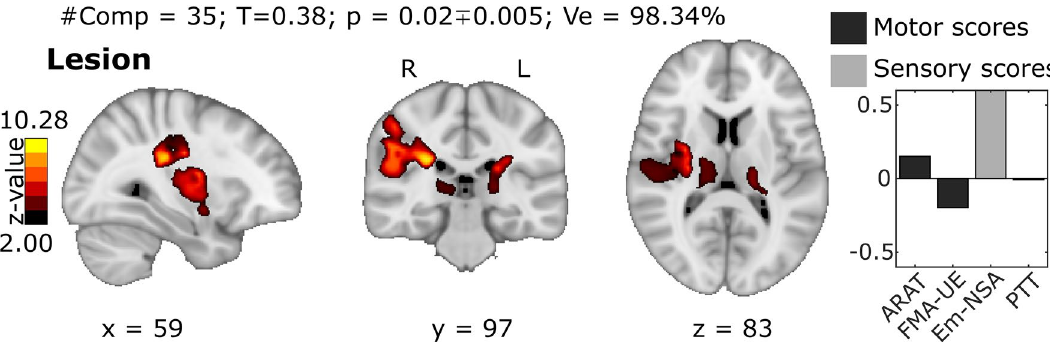
Figure 3. Brain maps with maximal behavioral association from Lesion Symptom Mapping and CCA. Final map corresponding to the CCA solution and providing the maximum correlation between the X variables (the PCA components from lesions maps) and the Y variables (a combination of several behavioral scores represented in Fig. 2). Together with the map, we provide the number of PCA components used (#Comp), the maximum correlation value (T), p-value (p) with the error intervals, and the amount of variance explained (Ve). For visualization, the map was threshold to Z > 2 , but a complete map without thersholding is given in Fig. S5. In the left panel we represent the behavioral weights corresponding to the maximum behavioral-association